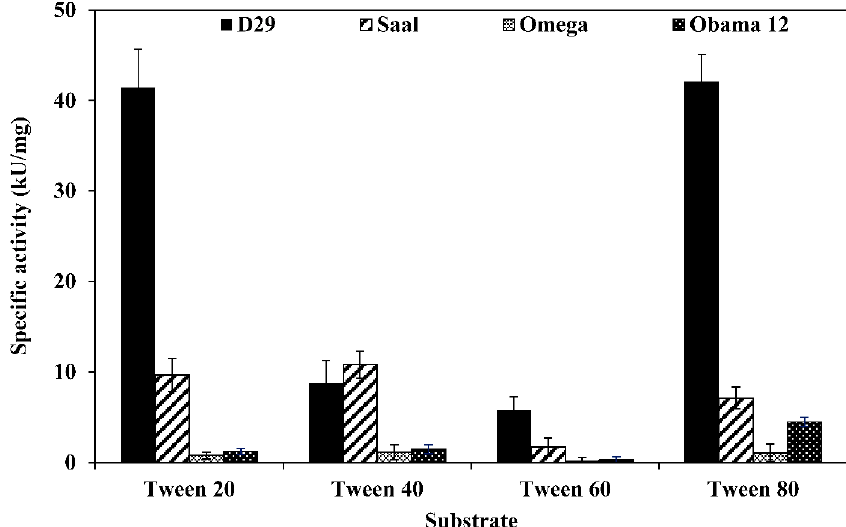
Figure 1. Specific activities of LysB-His 6 enzymes against different Tween substrates. Fifty microliters of LysB-His 6 solution (containing 0.175 µg of the enzyme) were mixed with 250 µL of the assay buffer (0.33% Tween, 50 mM Tris-HCl, 33 mM CaCl 2 , pH 8) and incubated at 30 ° C for 1 h. The absorbance